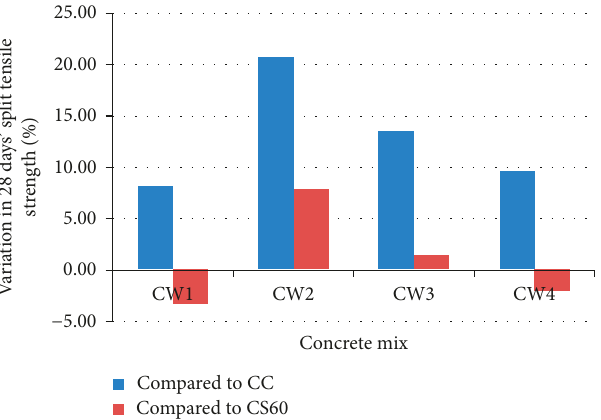
Figure 5: Variation in the split tensile strength of the Type B mixes.